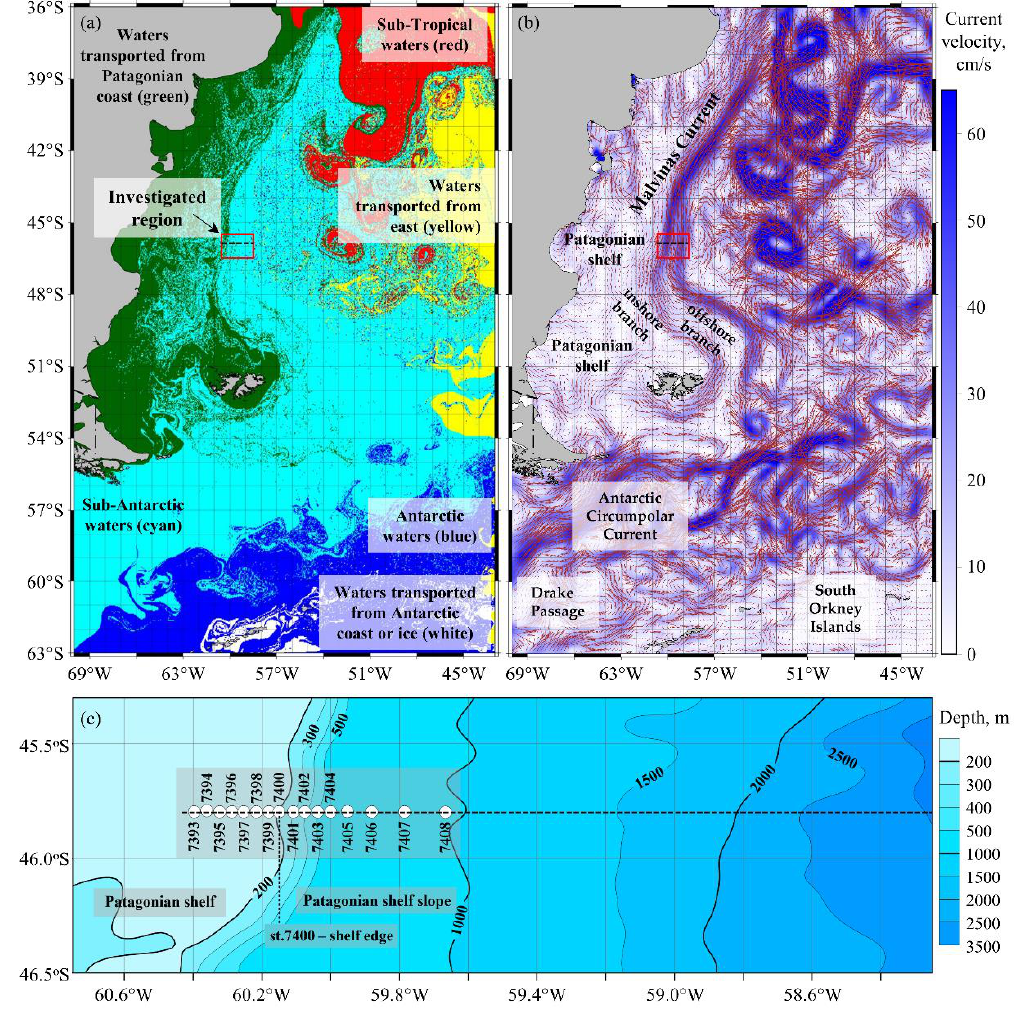
Figure 1. Map of the study site: Lagrangian map of the origin of waters ( a ); a diagram of currents in the southwestern part of the Atlantic on 21 February 2022 ( b ); map of the study site bathymetry and locations of stations ( c ). In Figure ( a ) blue color indicates the flow of water from the south, cyan is related to the flow from the west, red: from the north, yellow: from the east, green: from the Patagonian Shelf, white: from the Antarctic shelf or